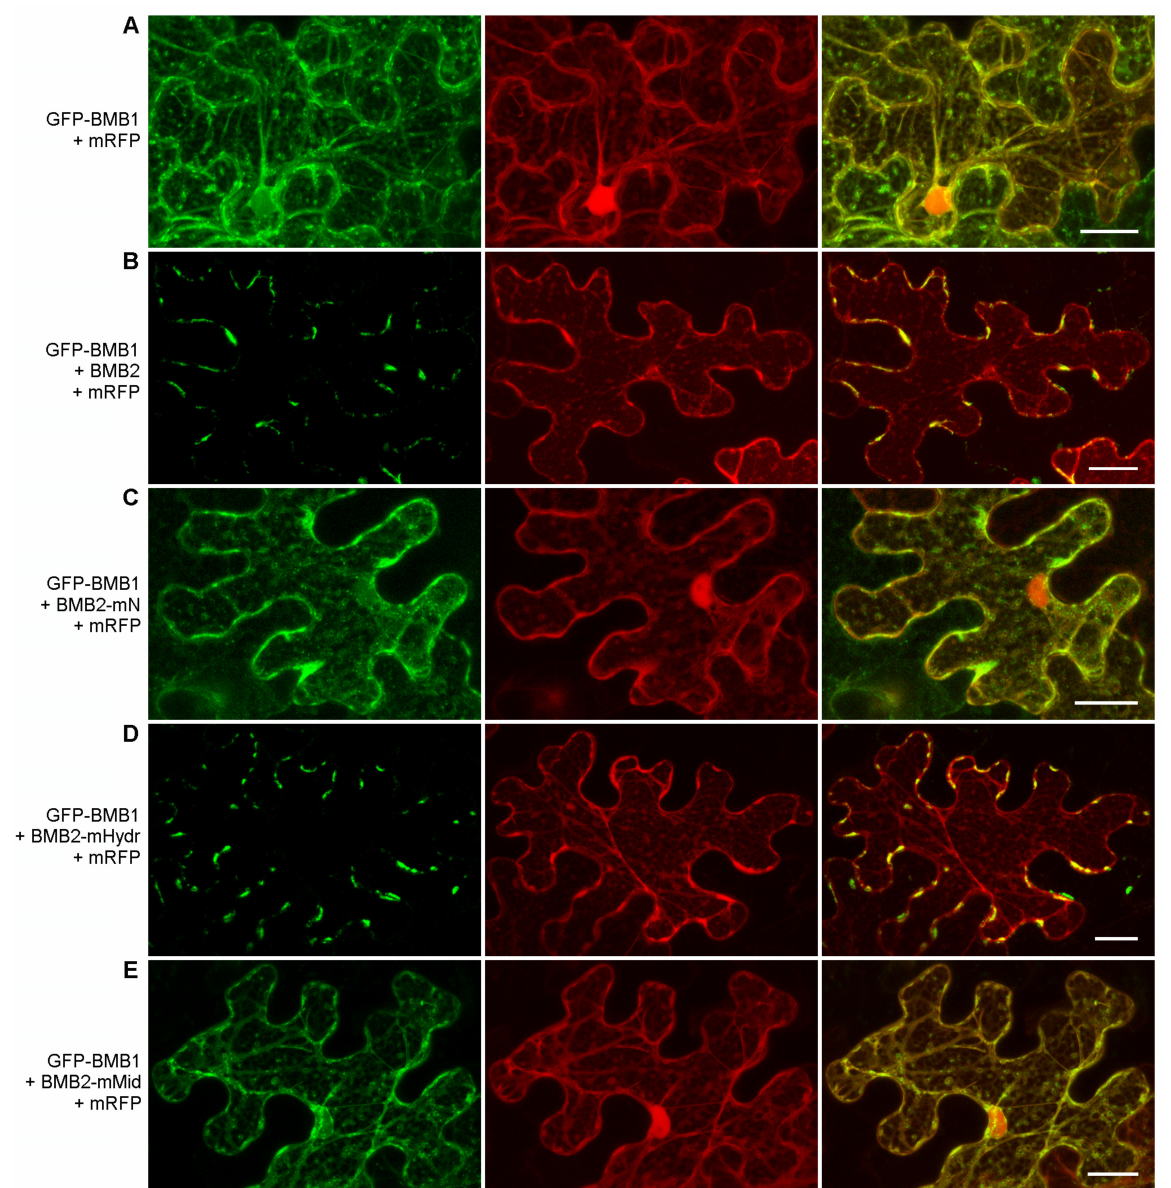
Figure 7. Analysis of the ability of BMB2 mutants to direct GFP-BMB1 to PAMBs. GFP-BMB1 was coexpressed with mRFP (used to visualize the cell shape and the nuclei) and BMB2 mutants ( C – E ), as indicated on the left. Coexpression with the wild type BMB2 ( B ) was used as a control. The coexpression of GFP-BMB1 with mRFP ( A ) represented a negative control. Left images, GFP channel. Center images, mRFP channel. Right images, superposition of images for GFP and mRFP channels. Scale bar, 20 µ